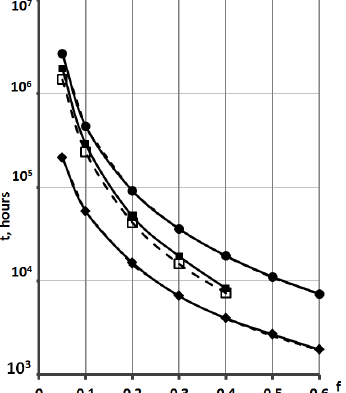
Figure 1. The effect of friction coefficient on the minimum durability of gear trains: